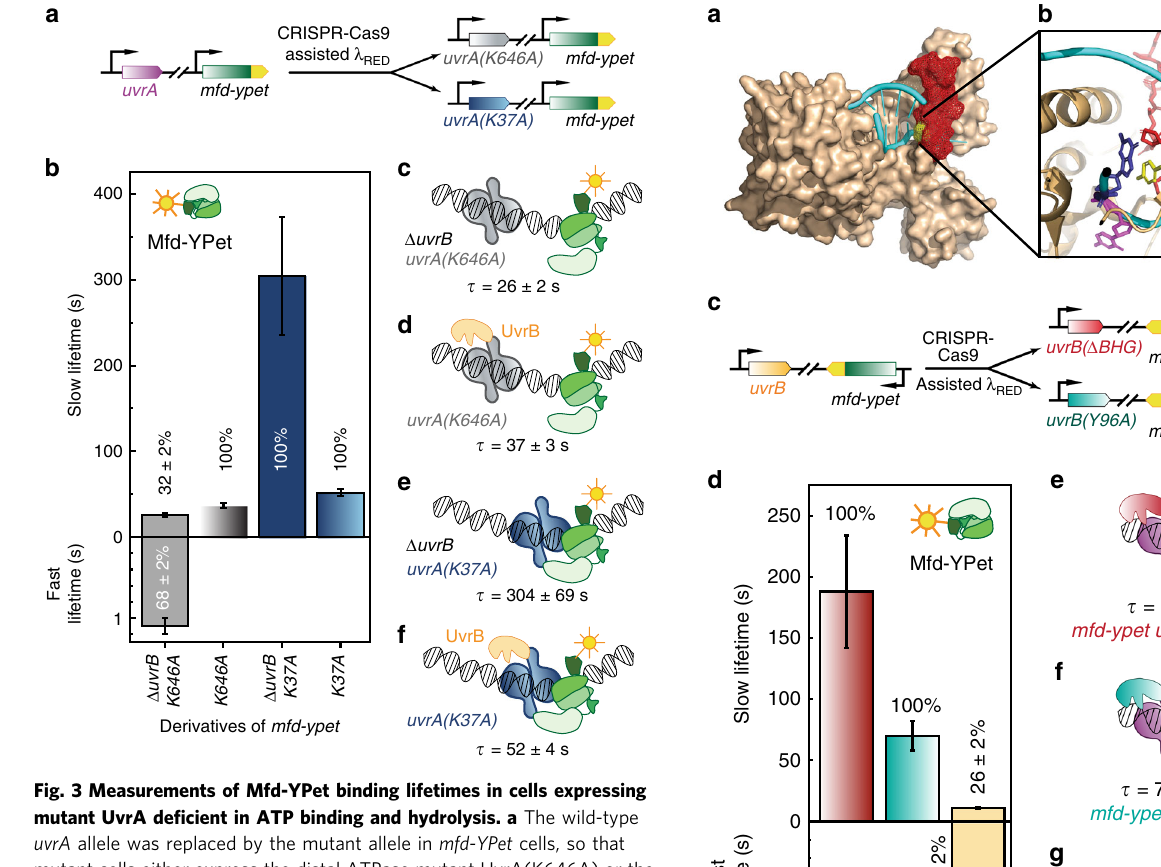
dissociation of Mfd-YPet. Error bars are standard deviations from